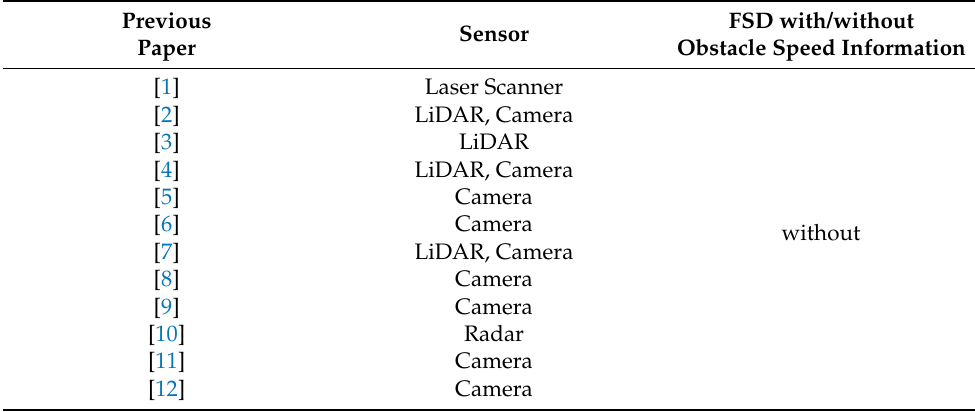
Table 1. Summary of previous papers